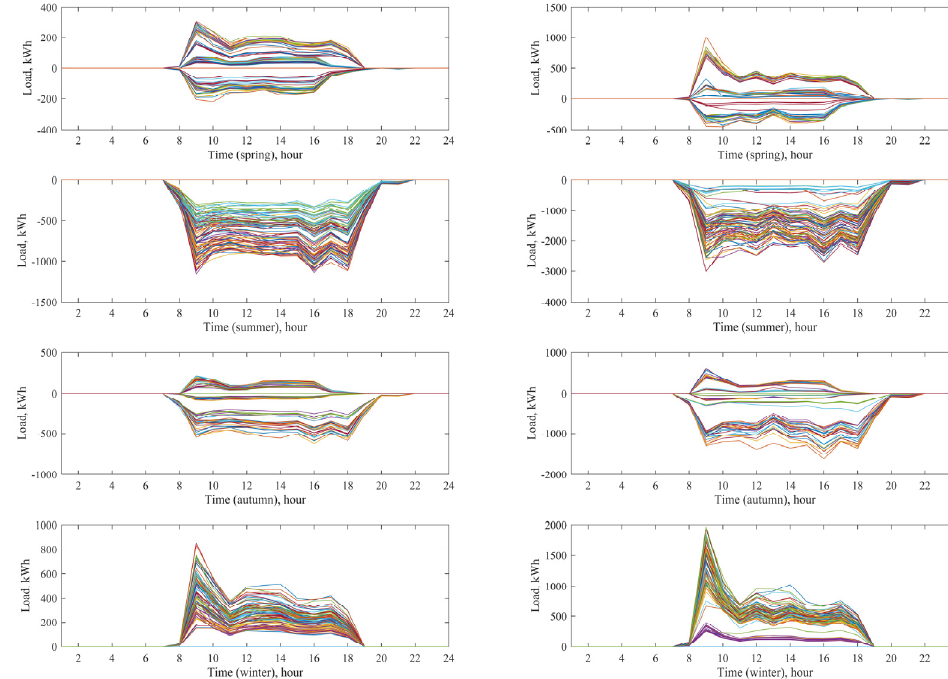
Figure A4. Typical daily change curve for the four seasons of office buildings (cold and heat load).